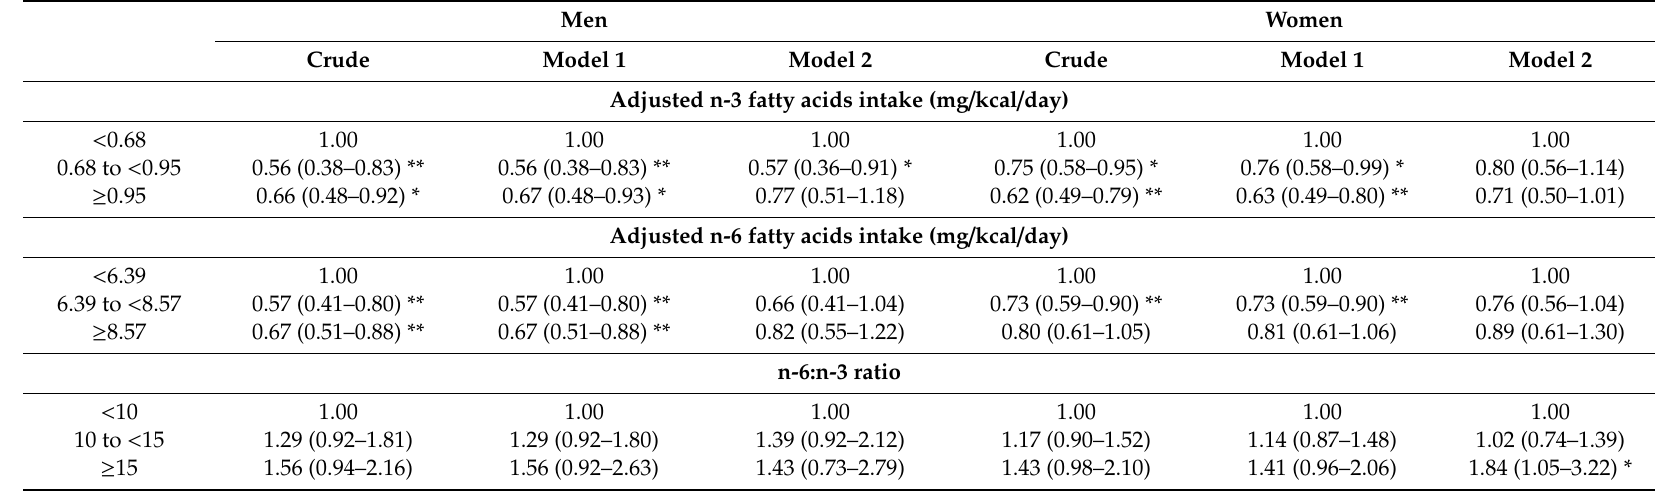
Table 4. The ORs (95%CIs) of depressive symptoms by adjusted dietary n-3 and n-6 fatty acids intake and n-6:n-3 ratio, stratified by gender. NHANES 2009–2016 ( n =